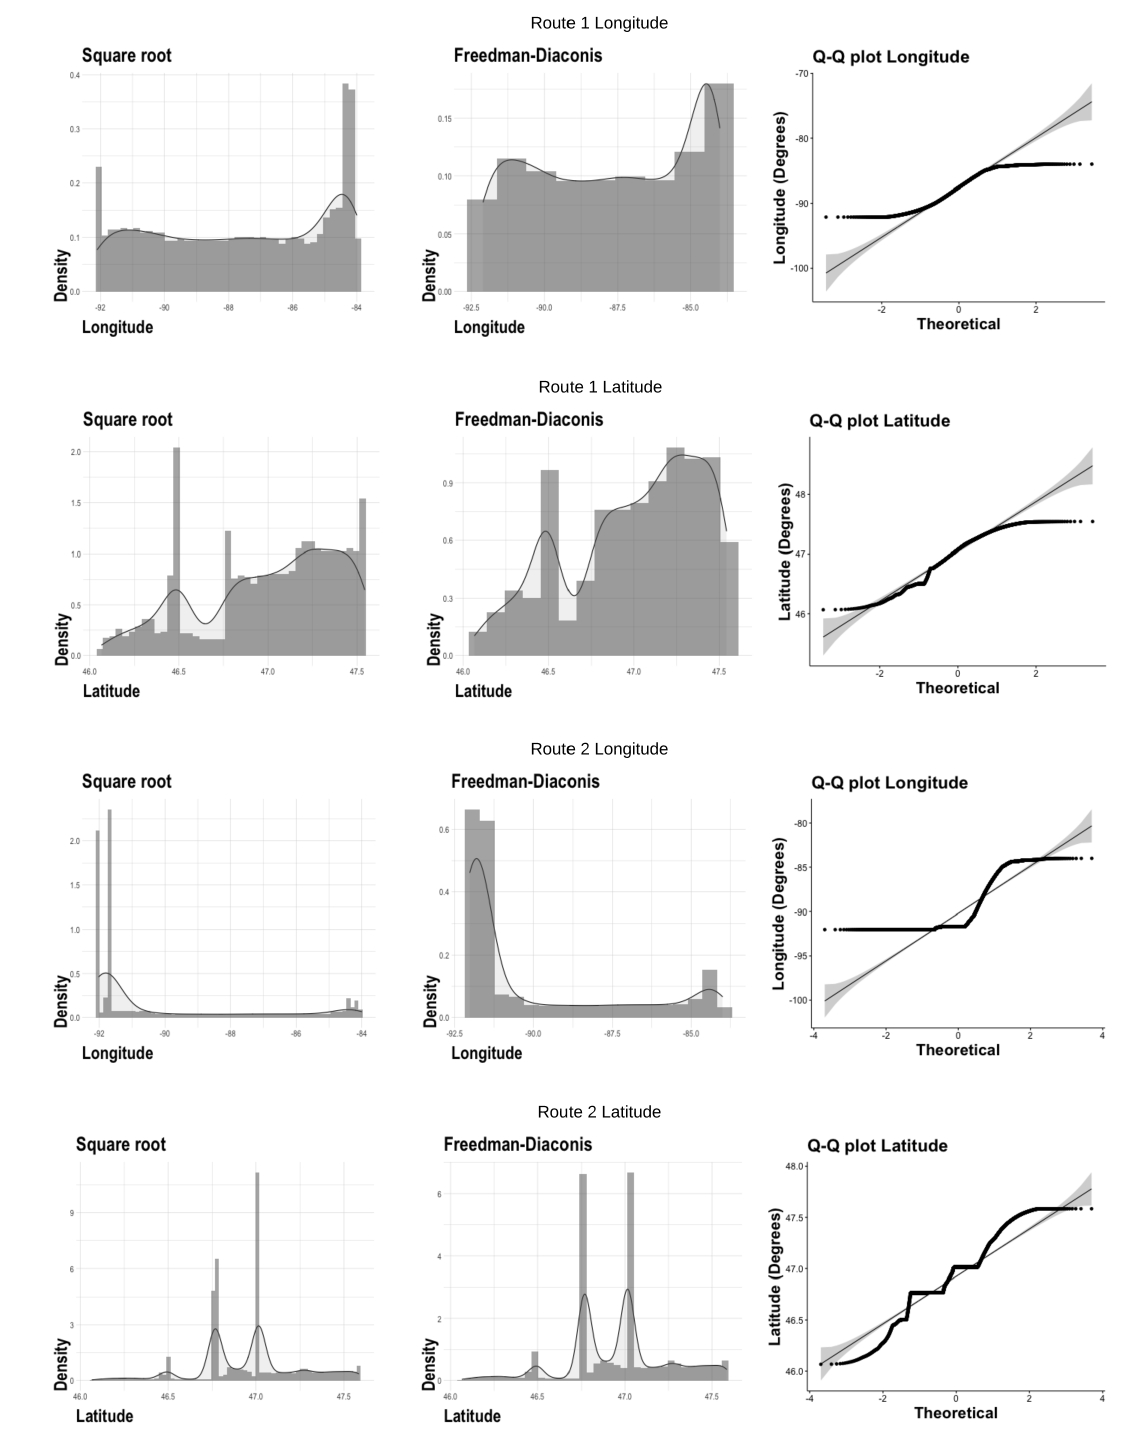
Figure 3. The Kernel Density Estimation (KDE) and histograms for each sample route (one and two) to visualize the differences. Freedman–Diaconis rule was used to calculate